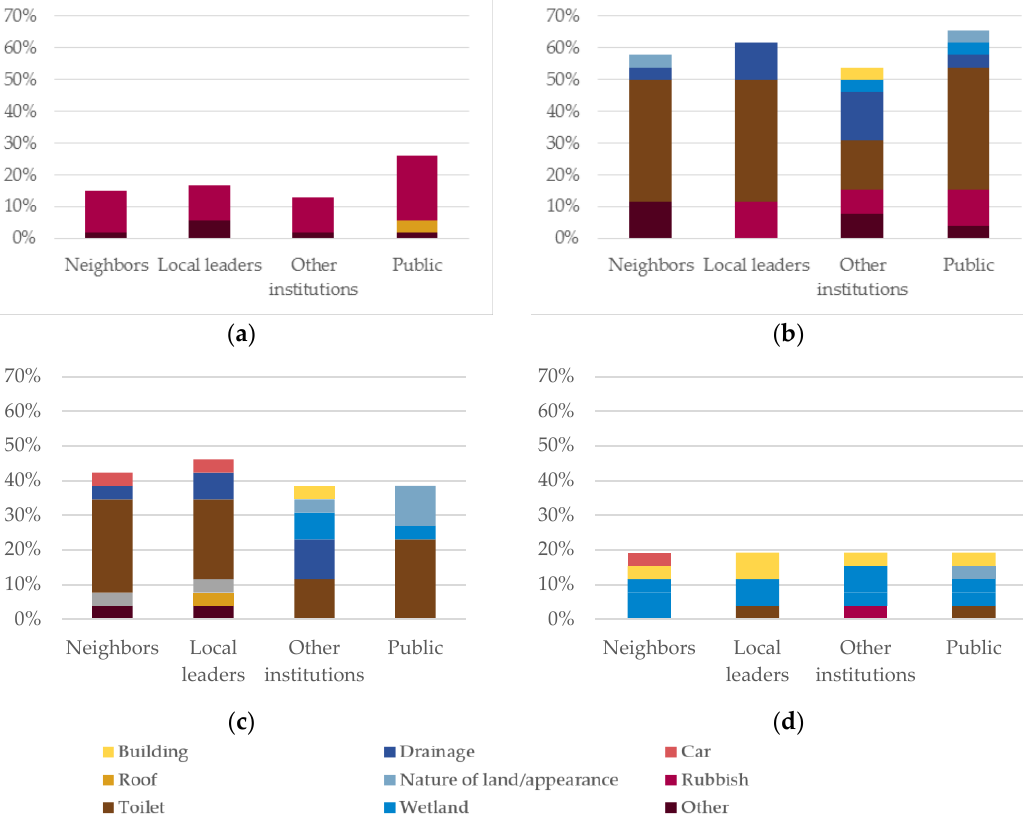
Figure 2. Percentage of questionnaire respondents considering an object visibly sensitive in: the high-resolution UAV orthomosaic in Kigali ( a ) and Dar es Salaam ( b ). The privacy sensitive objects in blurred orthomosaic ( c ) and vector map ( d ) also provided for the Dar es Salaam case study.